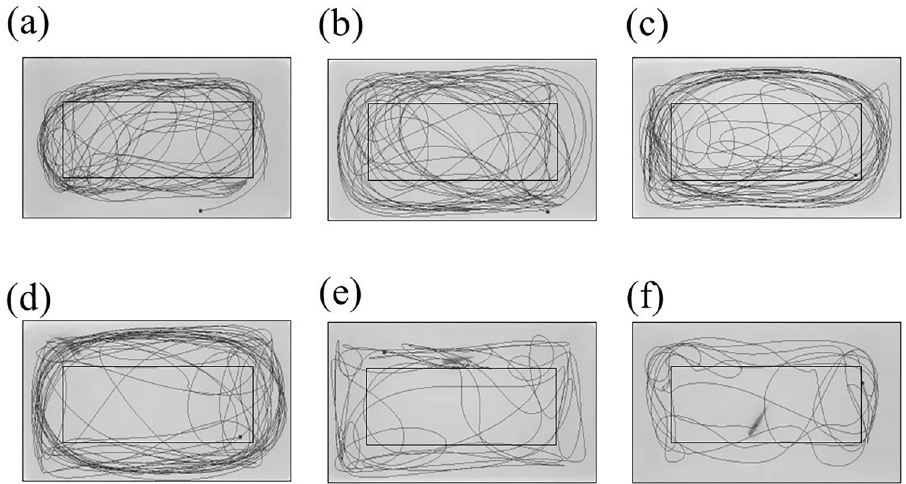
During the three-minute behaviour test, the freezing maintenance (duration and bouts) of the MPTP-injected zebrafish was higher and more frequent than the control zebrafish. MPTP- injected zebrafish spent more than two minutes in immobile condition 24h and 96h after injection (Fig 5A). Notably, on the 24 th hour after injection, MPTP-injected zebrafish alter- nated between swimming and freezing more frequently, as evidenced by the increased number of freezing bouts (Fig 5B).